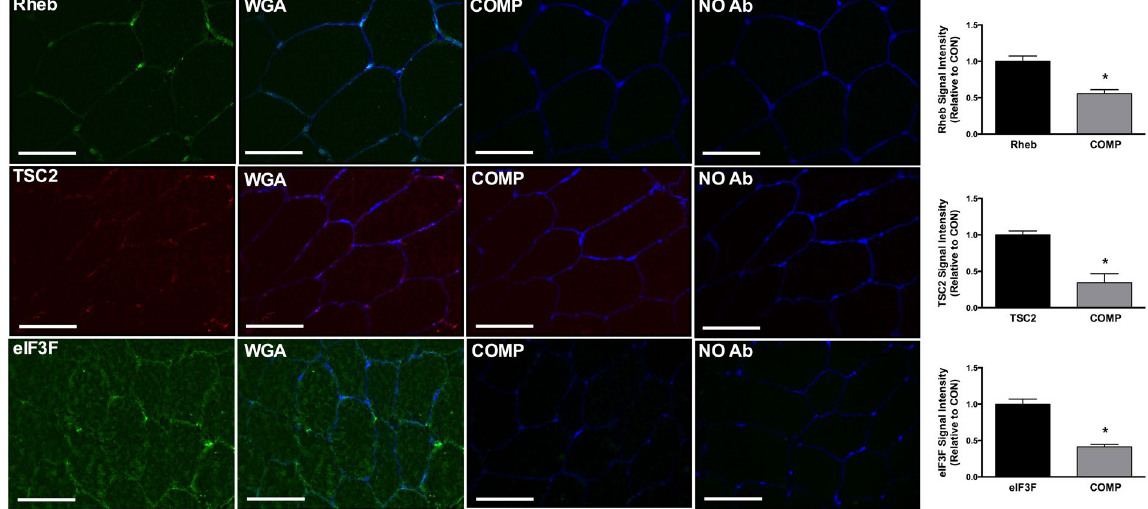
Figure 2. Rheb, TSC2 and eIF3F peptide competition assays. Immunofluorescence labeling of endogenous proteins was performed in human basal samples (CON – Left panel) as described in the Methods section. Regionality of staining is provided through co-staining with WGA or Dystrophin as a marker of the cell membrane. Competition (COMP) assays were performed to demonstrate antibody specificity of TSC2, eIF3F and Rheb. Non-specific binding/antibody efficiency was examined through imaging samples in which secondary antibody was used without prior primary antibody incubation (No Ab). All image processing was kept constant between images, including exposure time, gain, and image frame. * Significantly different to CON ( P < 0.05).